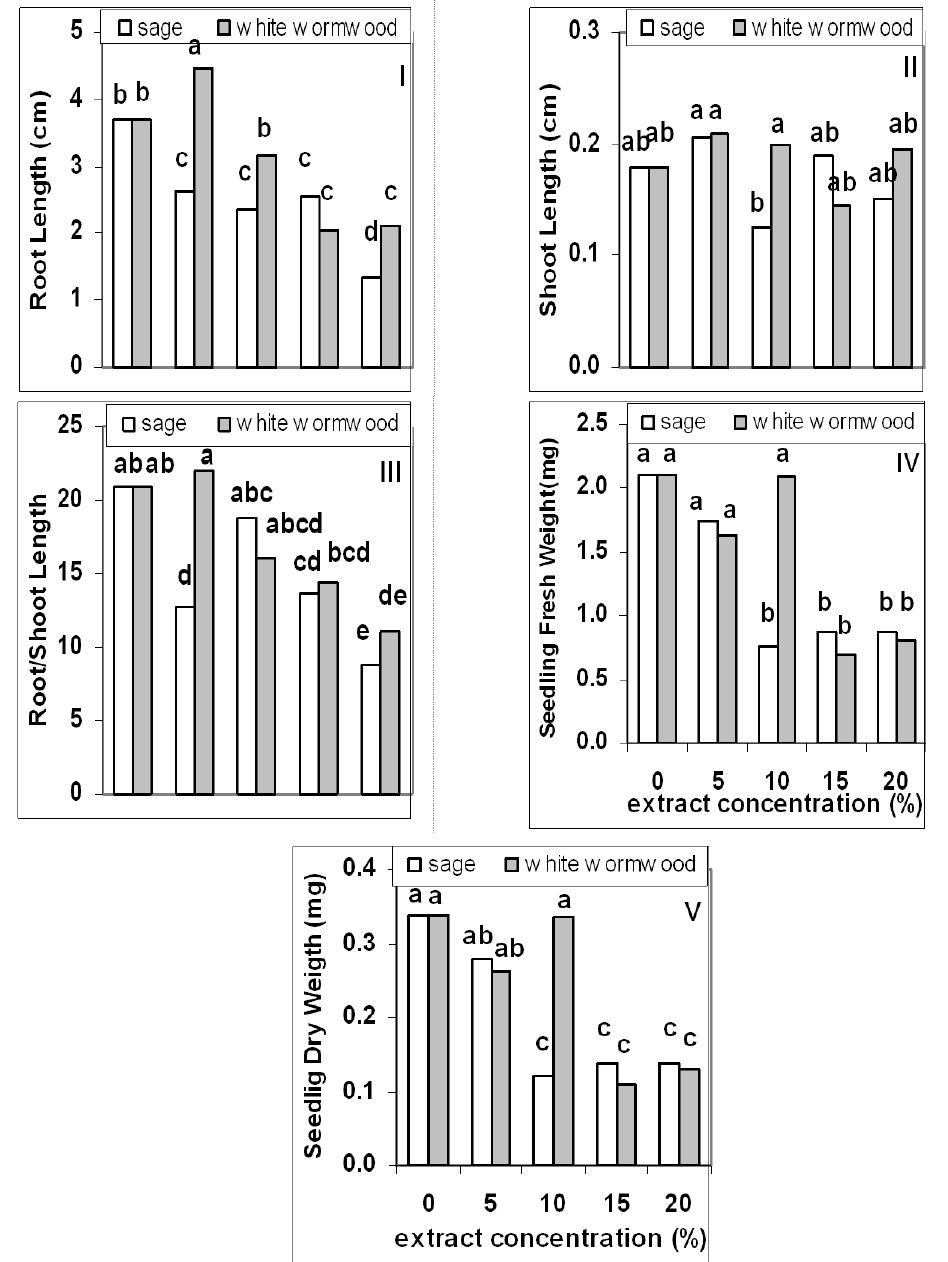
Fig. 2. Means comparisons of interaction effects between extract origin (sage and white wormwood) and concentration on root length (I), shoot length (II), root/shoot length (III), seedling fresh weight (VI) and seedling dry weight (V) of Portulaca oleracea. The same letters show non